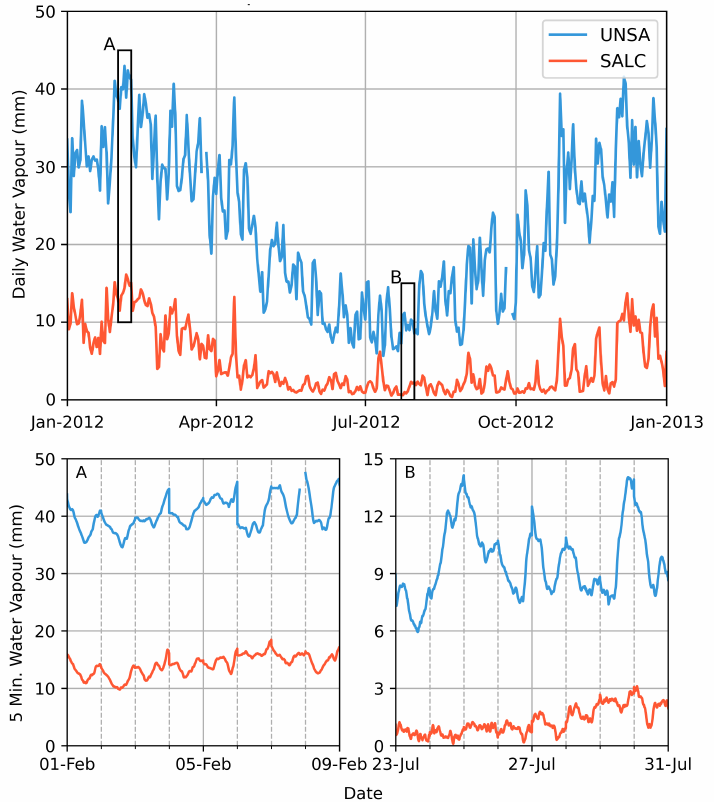
Figure 3. Top: Water vapour observations with 1 day sampling rate for the UNSA and SALC stations during 2012. Bottom: Detailed view with 1 h sampling rate during two incidents in February ( A ) and July ( B ) 2012. The panels have a different scales in their y-axes because of the contrasting water vapour levels during the wet and dry season and their different temporal